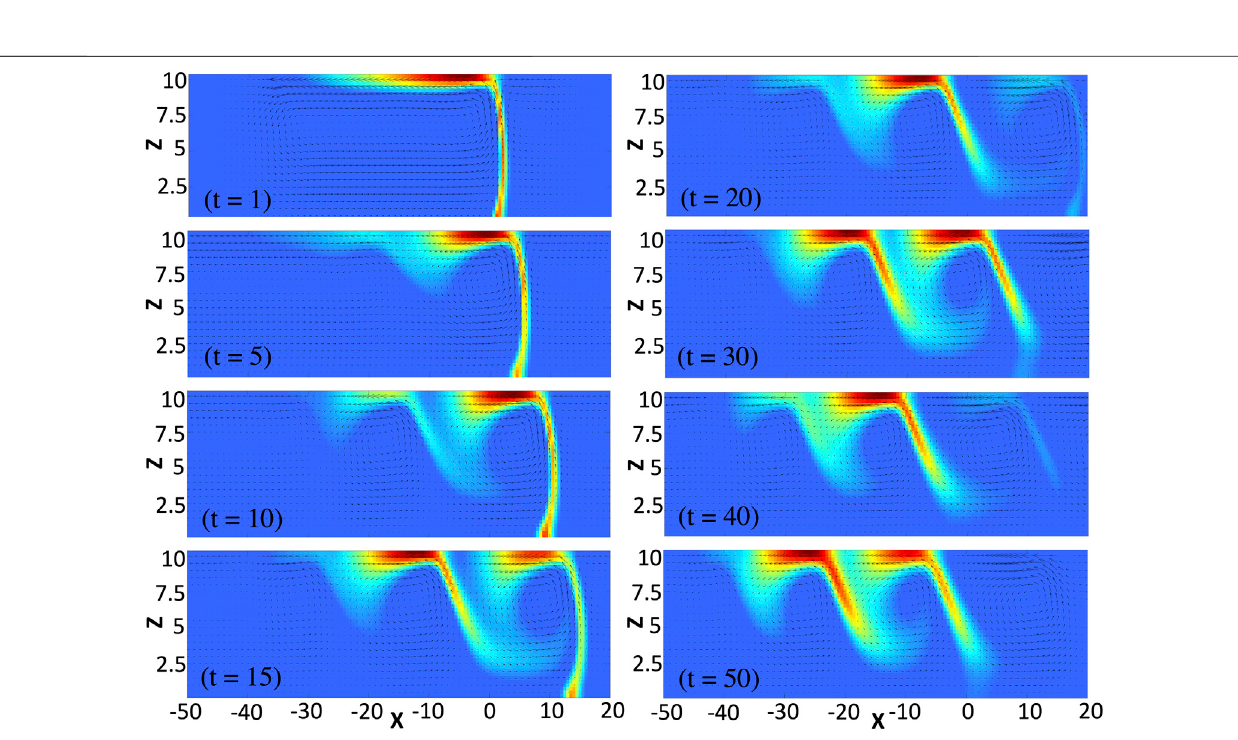
FIGURE 3 | Focus on the convective rolls centered on the reaction front at different times for the same parameters values as in Figure 2 . The fl uid velocity fi eld is superimposedona2Dplotoftheproductionratewhichrangesbetweenitsmaximumvalue,( ab ) max showninred,anditsminimumvalue,( ab ) min =0,showninblue.The front is mainly located at the surface and travels in the course of time discontinuously leading to oscillations in the surface tension pro fi les (cf: Figure 2 ). The velocity vectors are here tripled compared to their effective length to allow for a better